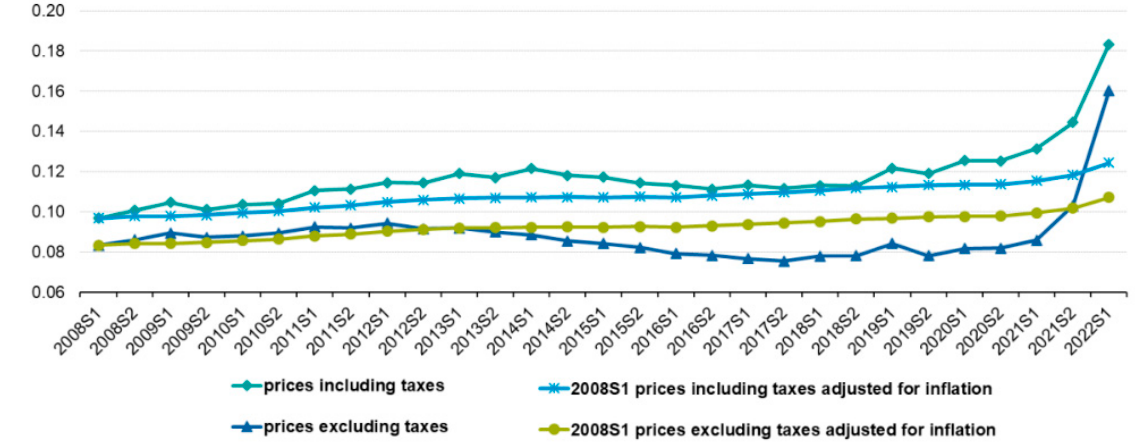
Figure 8. Development of electricity prices for non-household consumers, EU, 2008–2022 (in EUR per kWh). Source: Eurostat [91].